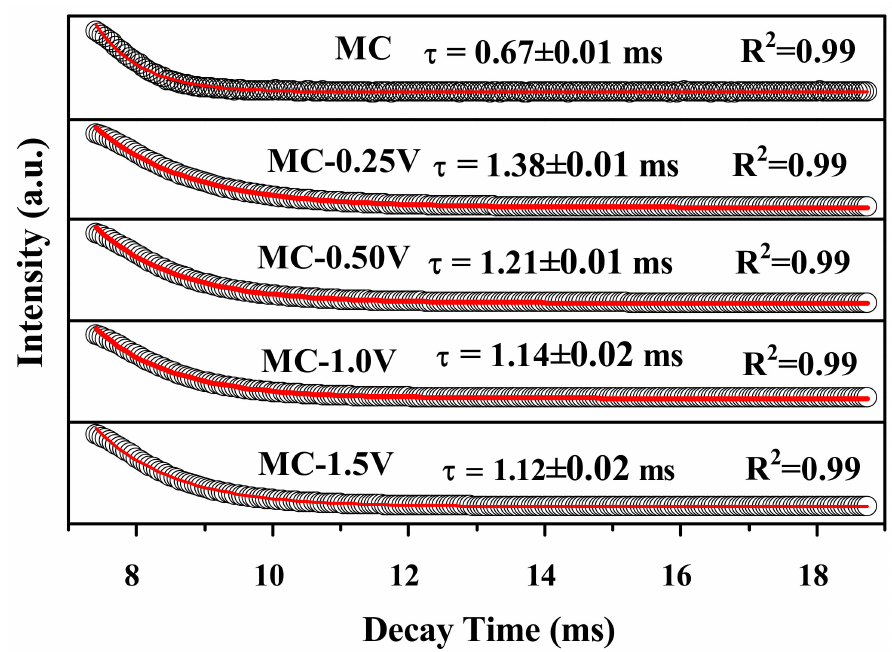
Figure 11. Fluorescence decay curves for the 617 nm emission of MC and MC- R